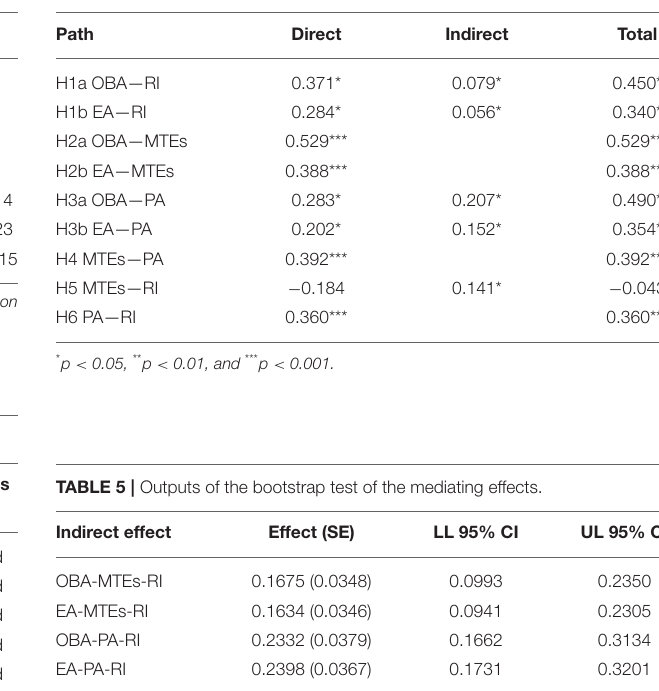
TABLE 4 | Direct, indirect, and total effects of relationships.